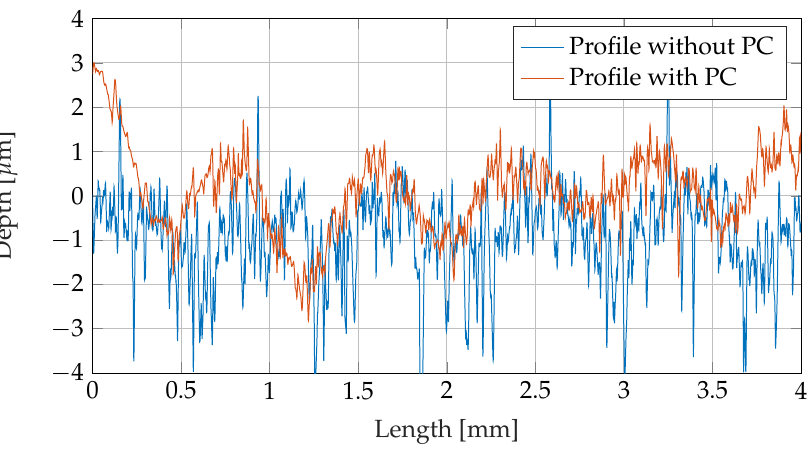
Figure 4. Roughness profiles before (blue) and after (orange) PC